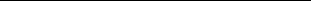
Figlio di Nikolaj e della poetessa Anna Achmatova, Lev Gumilev vede l’etnia come una categoria naturale, determinata dalle radiazioni provenienti dalla biosfera, che attraverso la fotosintesi producono l’energia che causa “la passionarietà” responsabile dei conflitti etnici (si veda ad es. Gumilev